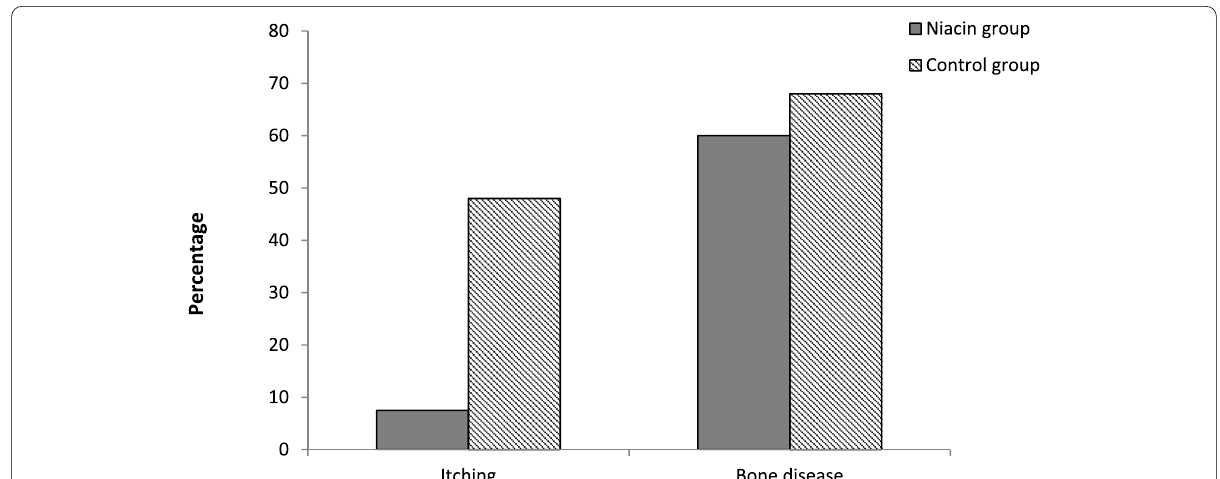
Fig. 4 Third month follow‑up: itching and mineral bone disease among the studied groups